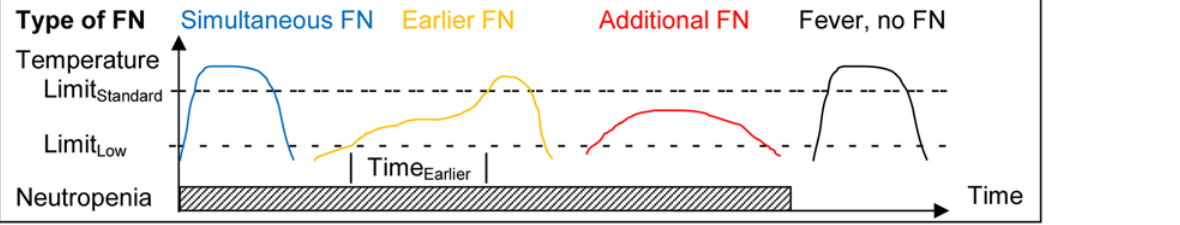
Figure 1. Types of FN diagnoses applying a low versus high